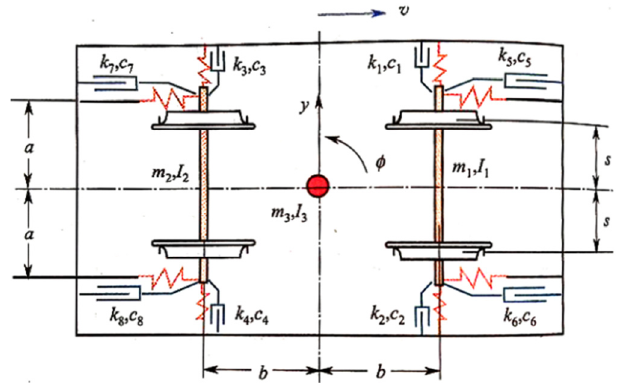
Figure 8. Simplified model of the bogie [33].